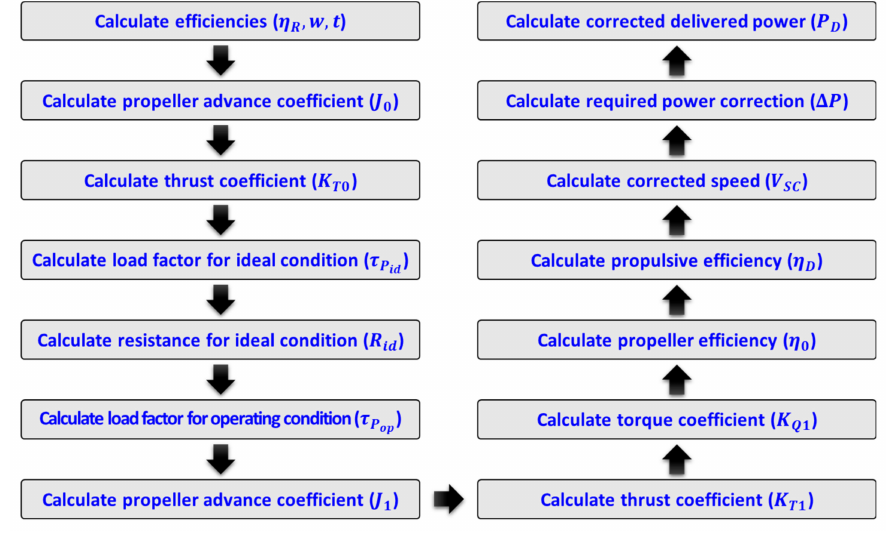
Figure 6. Process of power evaluation using